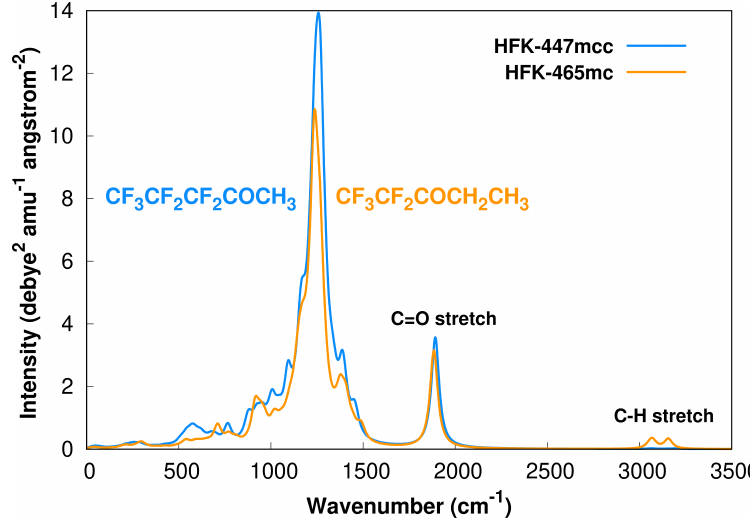
Figure 1. Boltzmann weighted (298.15 K) harmonic M08-HX/pcseg-2 calculated IR spectra of HFK- 447mcc and HFK-465mc, including all obtained conformers for both